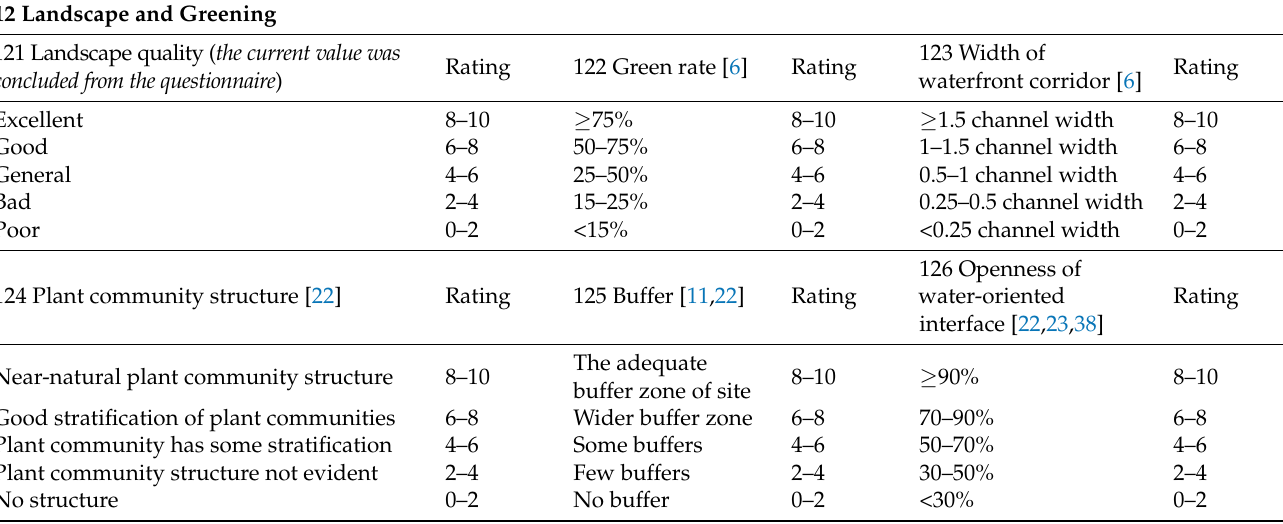
Table 7. Rating for elements of landscape and greening layer in ecological subsystem.